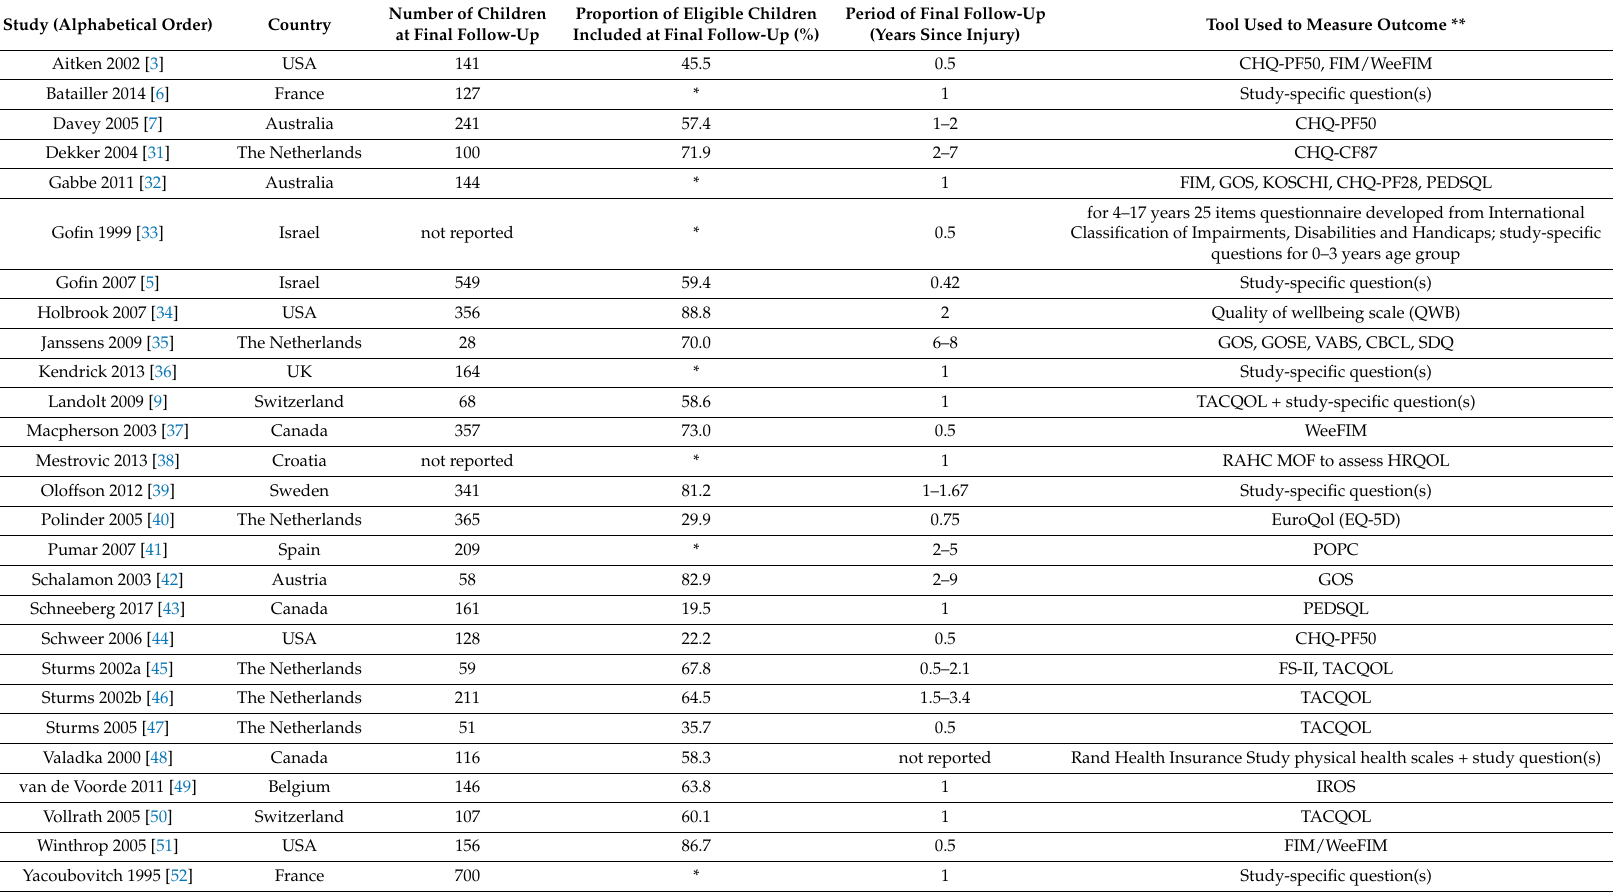
Table 2. Specific characteristics of included studies including setting, measurement tools and follow-up